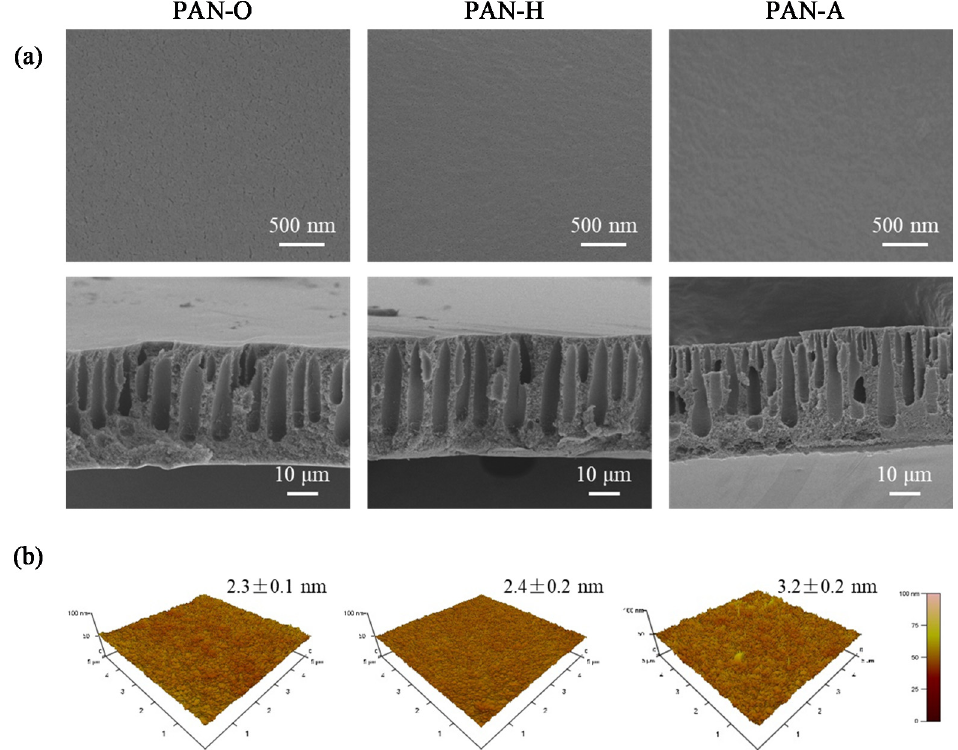
Figure 2. Comparison of the geometrical characteristics of the original PAN substrate and the PAN substrates with the heat treatment and alkaline treatment via ( a ) SEM and ( b ) AFM. The SEM images demonstrate both the top and cross-sectional views of the PAN substrates; the AFM images are displayed with the associated roughness values in terms of the RMS.